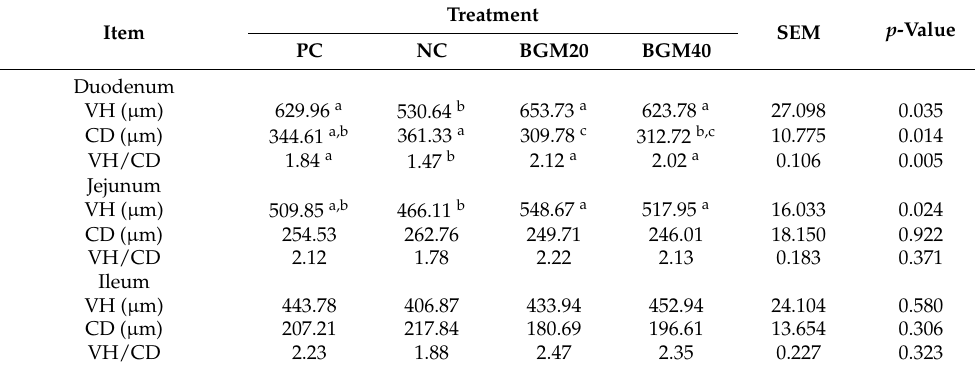
Table 7. Effect of dietary BGM with combined enzymes inclusion on intestinal morphology of growing pigs 1